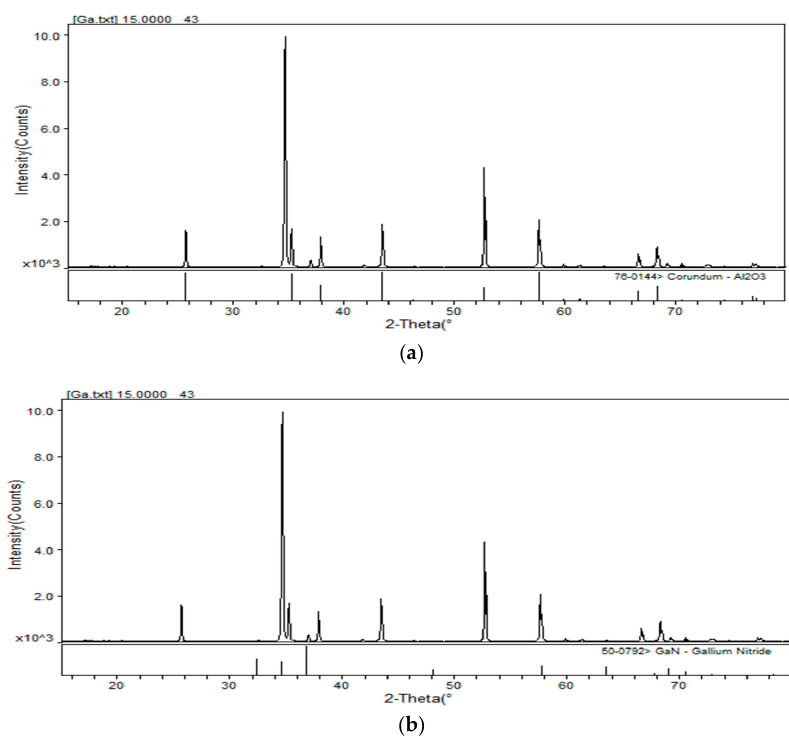
Figure 3. ( a ) Microstructure of matrix layer by scanning electron microscope (SEM) analysis; ( b ) The composition of matrix layer by energy-dispersive X-ray spectroscopy (EDS) analysis; ( c ) Microstructure of coating layer by scanning electron microscope (SEM) analysis; ( d ) The composition of GaN coating layer by energy-dispersive X-ray spectroscopy (EDS) analysis.